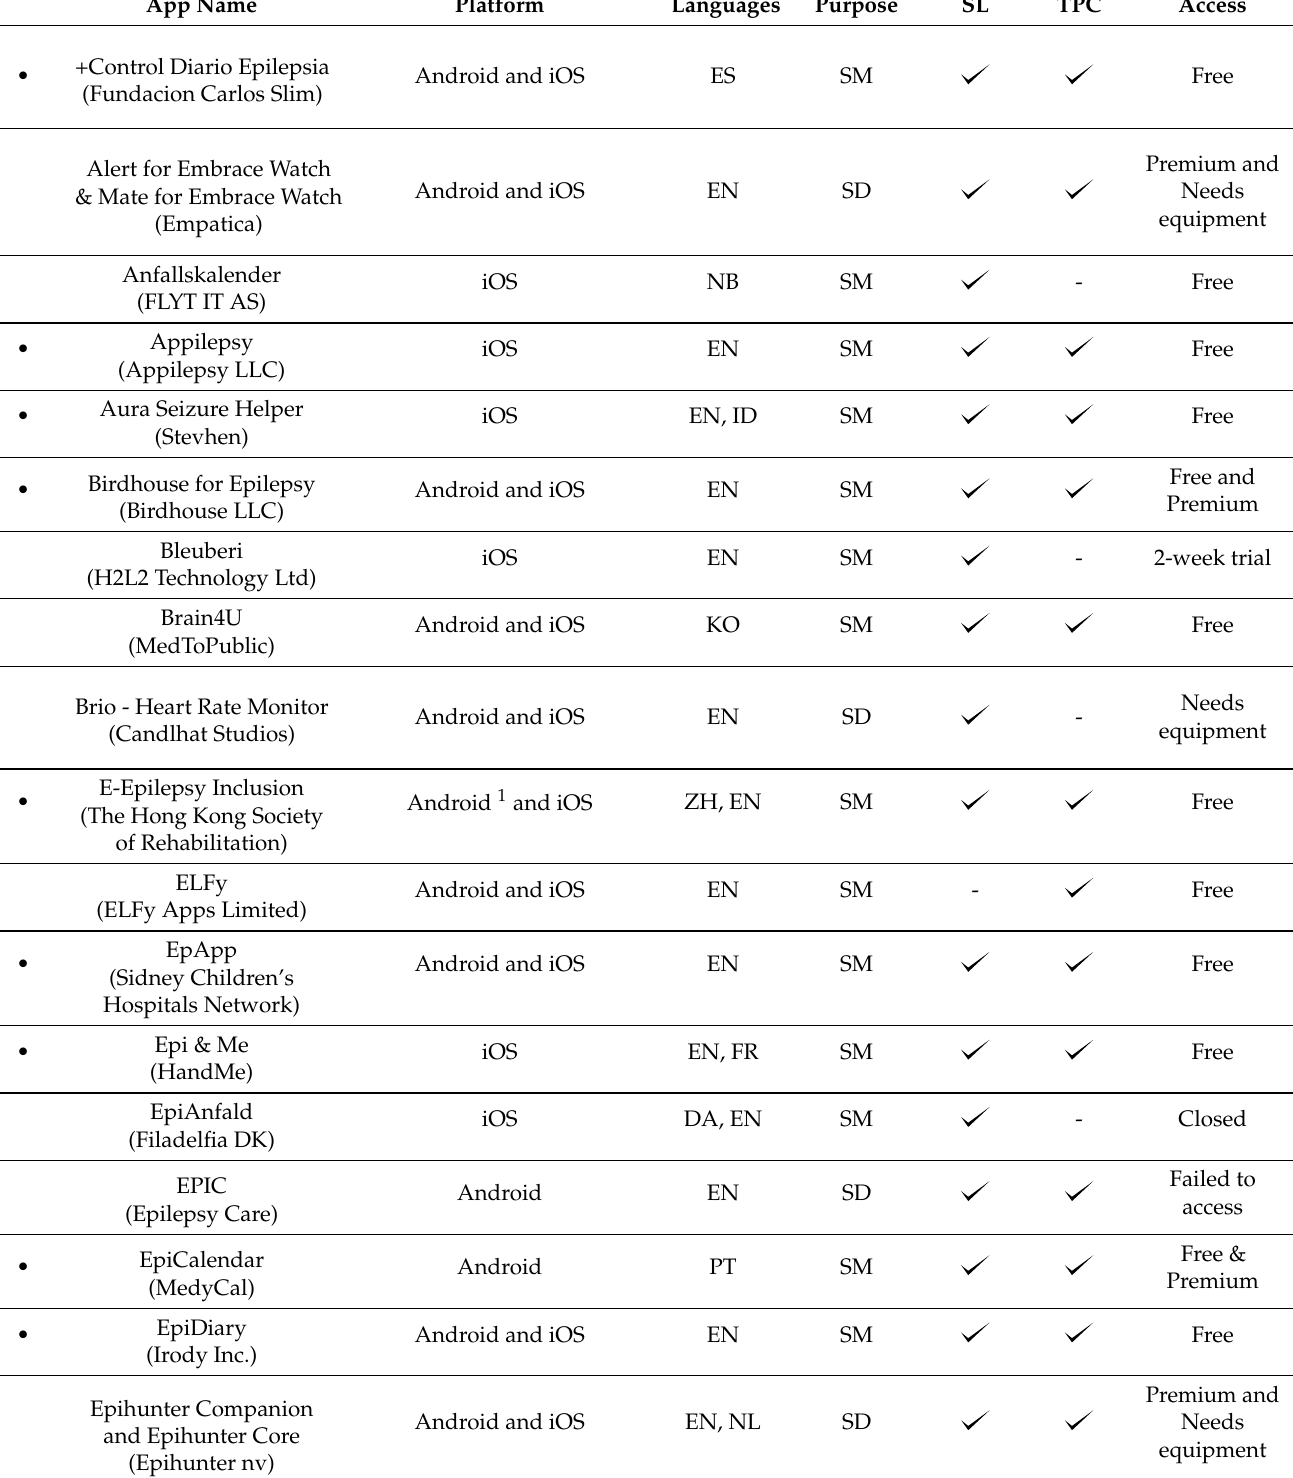
Table A1. Mobile applications for epilepsy management and detection. SL is the seizure log, and TPC is third-party communication. The black dot indicates whether the app was selected for the final pool of